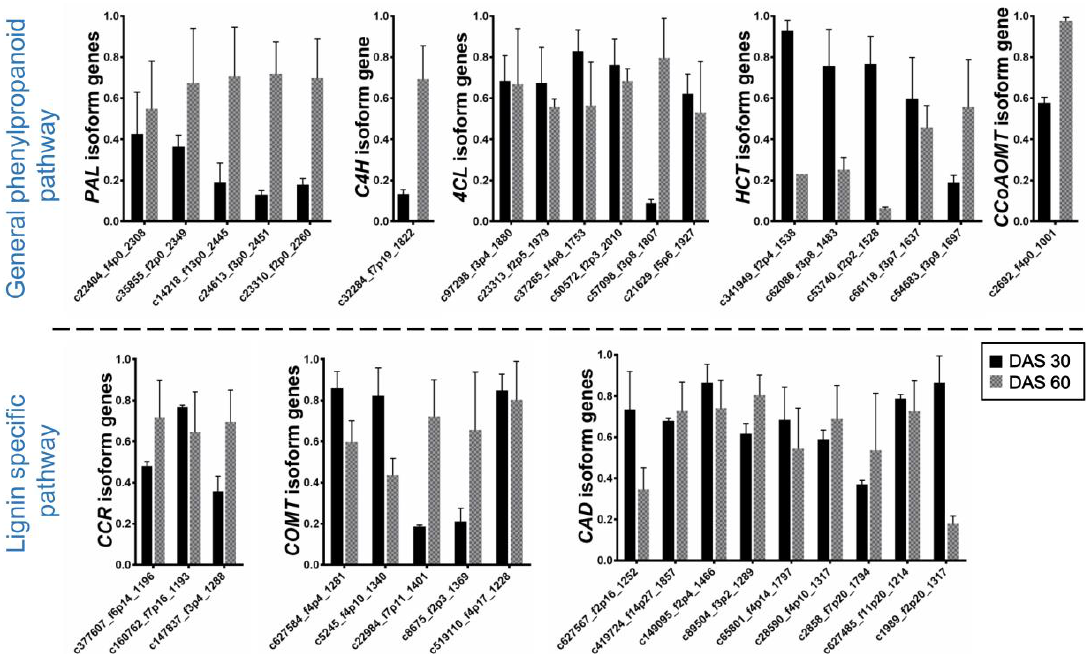
Figure 7. Relative expression time course at 30 and 60 days after seeding of eight genes involved in lignin biosynthesis ascertained by qPCR. Primers were designed on the respective gene sequences (deposited in NCBI database) and used as reference to compare the expression of the current data.